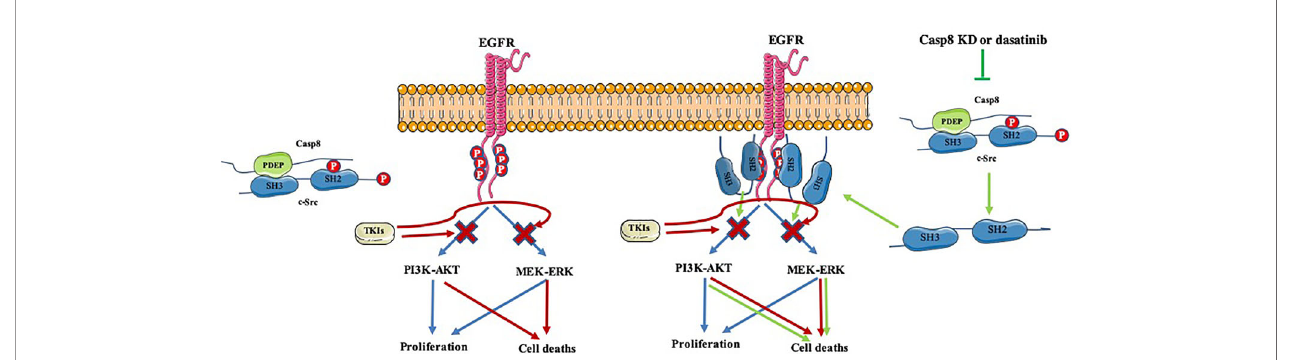
FIGURE 8 | A schematic diagram of synergic effects of inactivated c-Src and